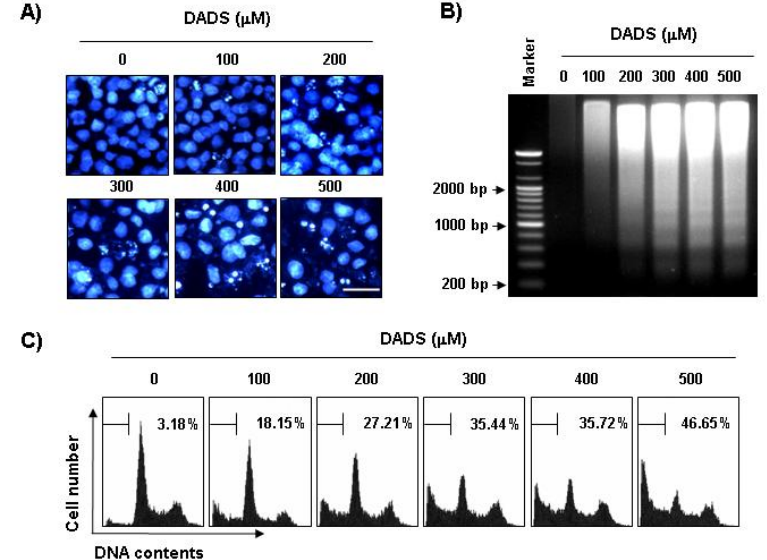
Figure 2. Induction of apoptosis by DADS in DU145 cells. ( A ) The cells were incubated with the indicated concentrations of DADS for 48 h, fixed and stained with DAPI